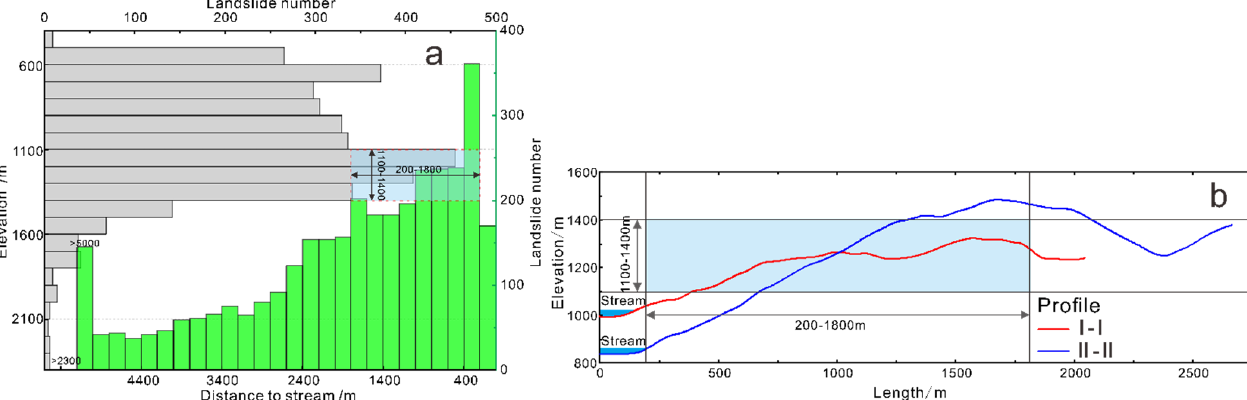
Figure 17. The influence of the elevation and distance to the stream on the landslide concentration. ( a ) The distribution of landslides per elevation class. ( b ) Corresponding hill profiles, the locations I–I and II–II are shown in Figure